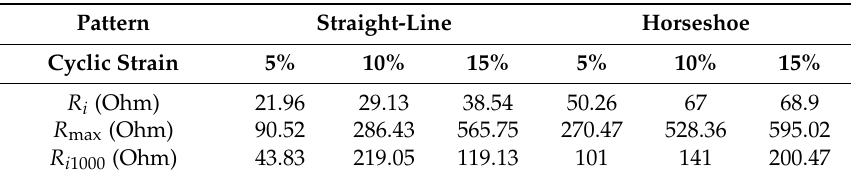
Figure 14. Normalized resistances of ( a ) the straight line, and ( b ) the 1-layer 2 mm horseshoe patterns, printed on the optimal radially pre-stretched sample cycled up to 1000 cycles at various strain values. Table 2. The initial, maximum, and final resistances of the straight line and the one-layer 2 mm horseshoe pattern during the radial cyclic test.